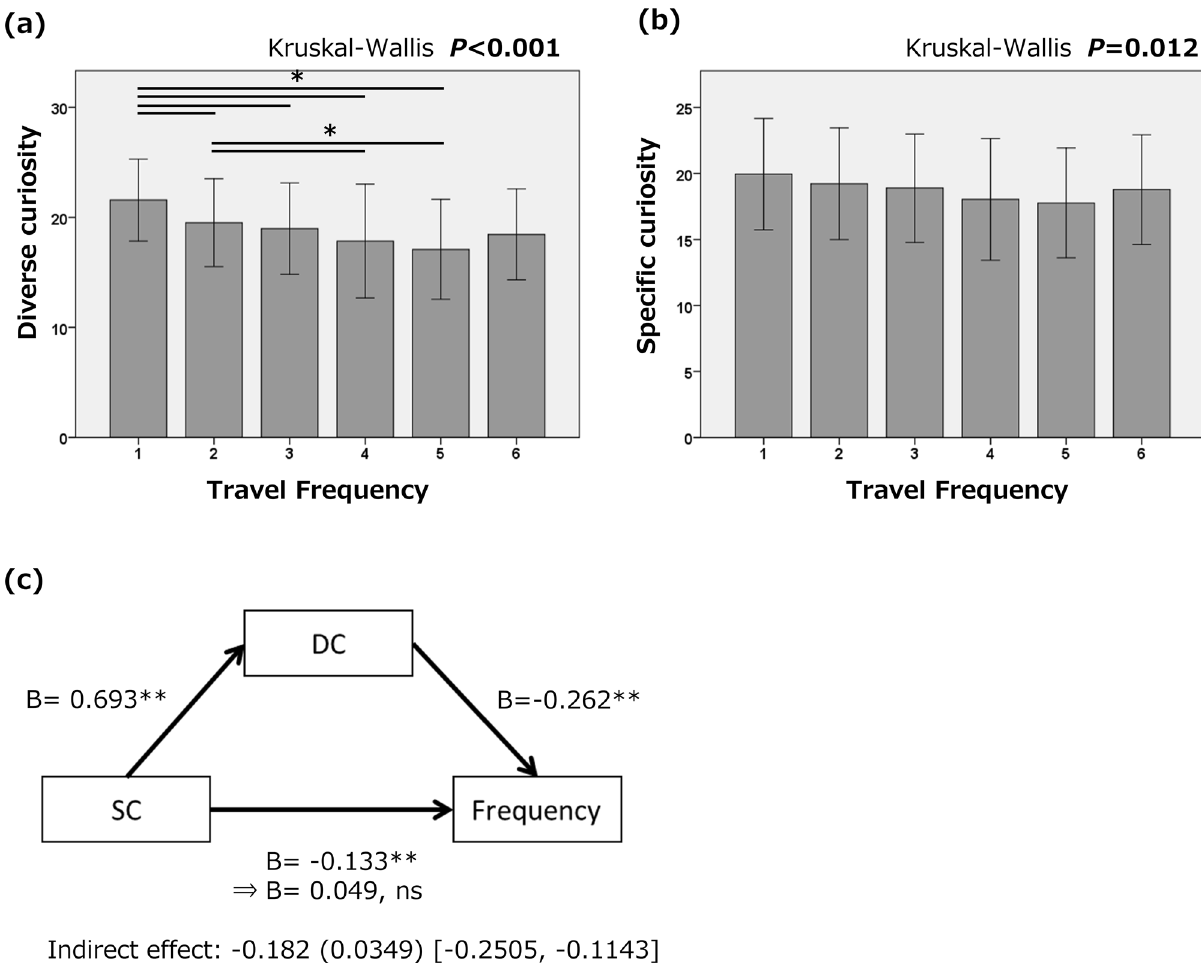
Fig. 2 Relationship between travel frequency and epistemic curiosity. Travel frequency: (1) More than 10 times per year, (2) 5 – 9 times per year, (3) 3 – 4 times per year, (4) 1 – 2 times per year, (5) Once in 2 – 3 years, (6) Less than once in 2 – 3 years (Hardly ever), DC diverse curiosity, SC speci fi c curiosity. The bar charts show the test scores (mean ± SD). a Signi fi cant DC difference between 1 – 2/3/4/5, 2 – 4/5 (* p < 0.05). b Signi fi cant SC difference between groups were observed using the non-parametric Kruskal – Wallis test ( p = 0.012), although no signi fi cant difference was seen in post-hoc pairwise comparison of Dunn ’ s test with Bonferroni error correction. c Mediation analysis between DC, SC and travel frequency. The positive effect of SC on travel frequency is completely mediated by DC (** p <